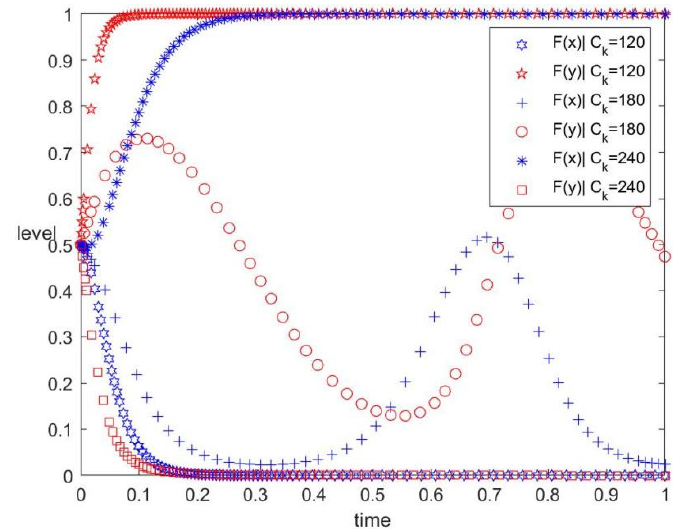
Figure 2. Evolution track under different additional initial investment.